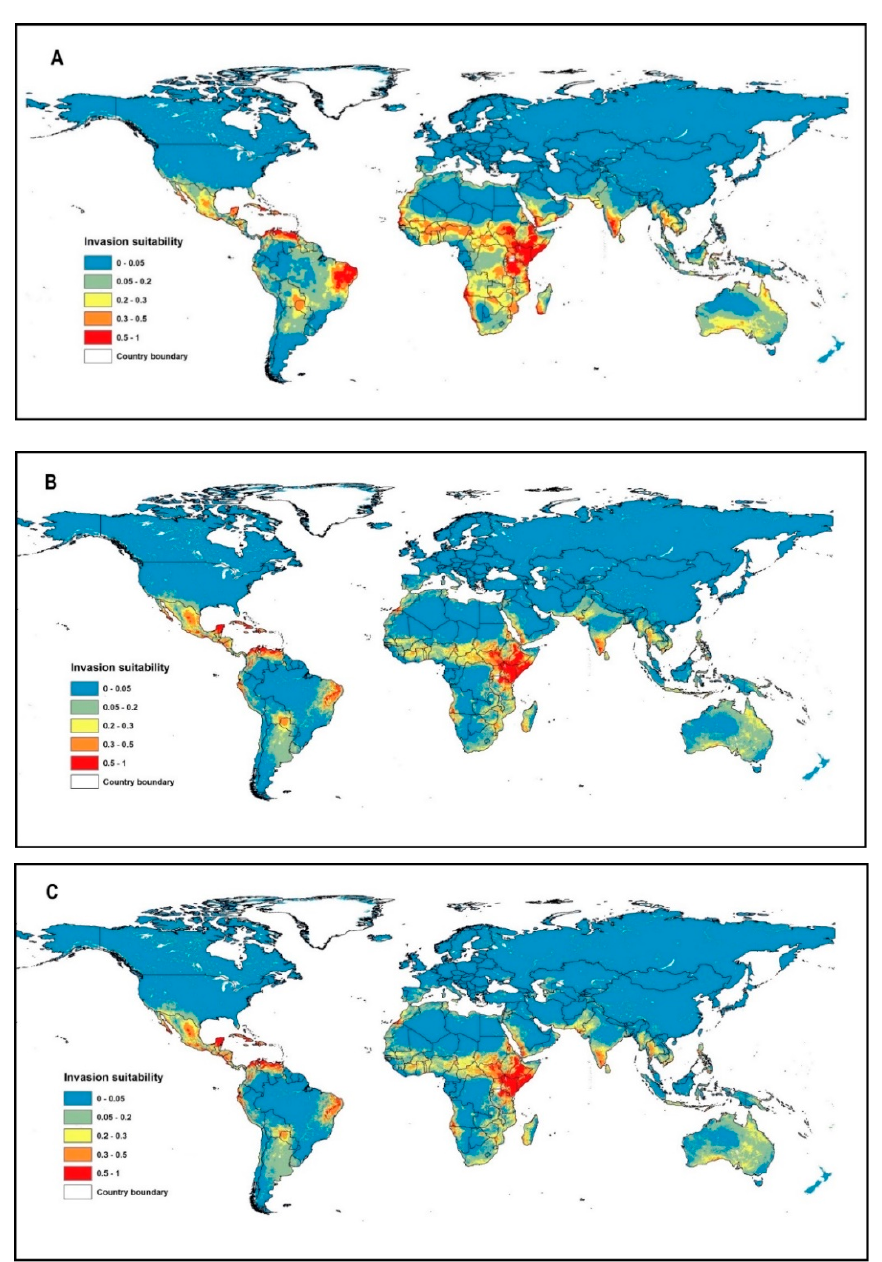
Figure 2. Global invasion risk (potential habitat suitability) of P. juliflora according to the three different models: ( A ) Climate model, ( B ) Climate and soil model ( C ) Climate, soil, and human influence mode.